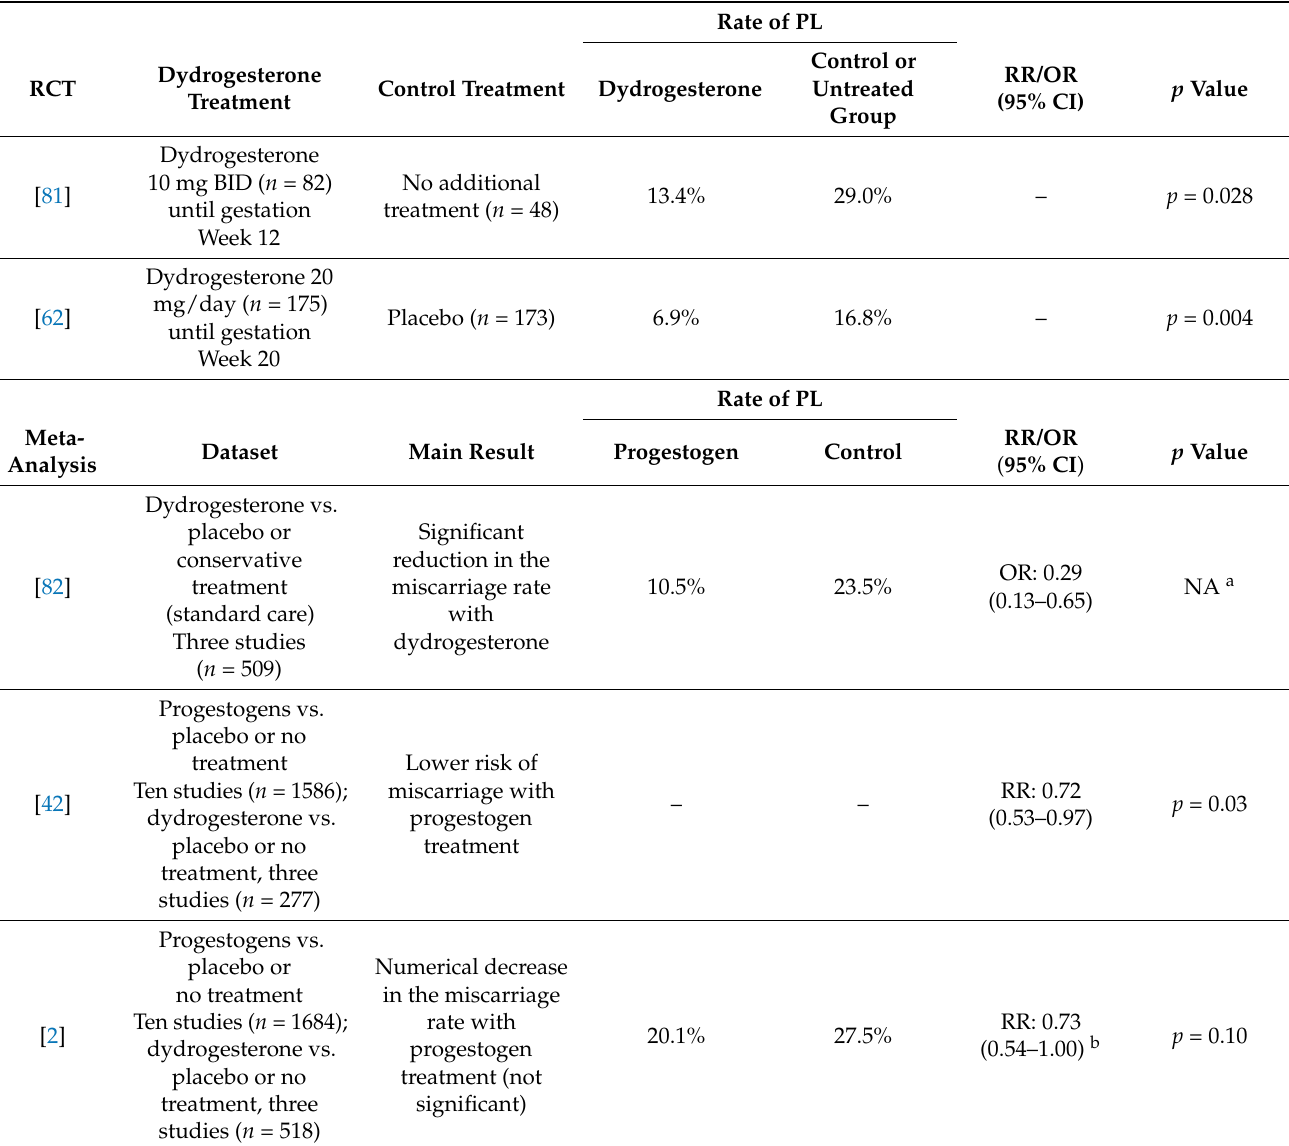
Table 3. Dydrogesterone in recurrent pregnancy